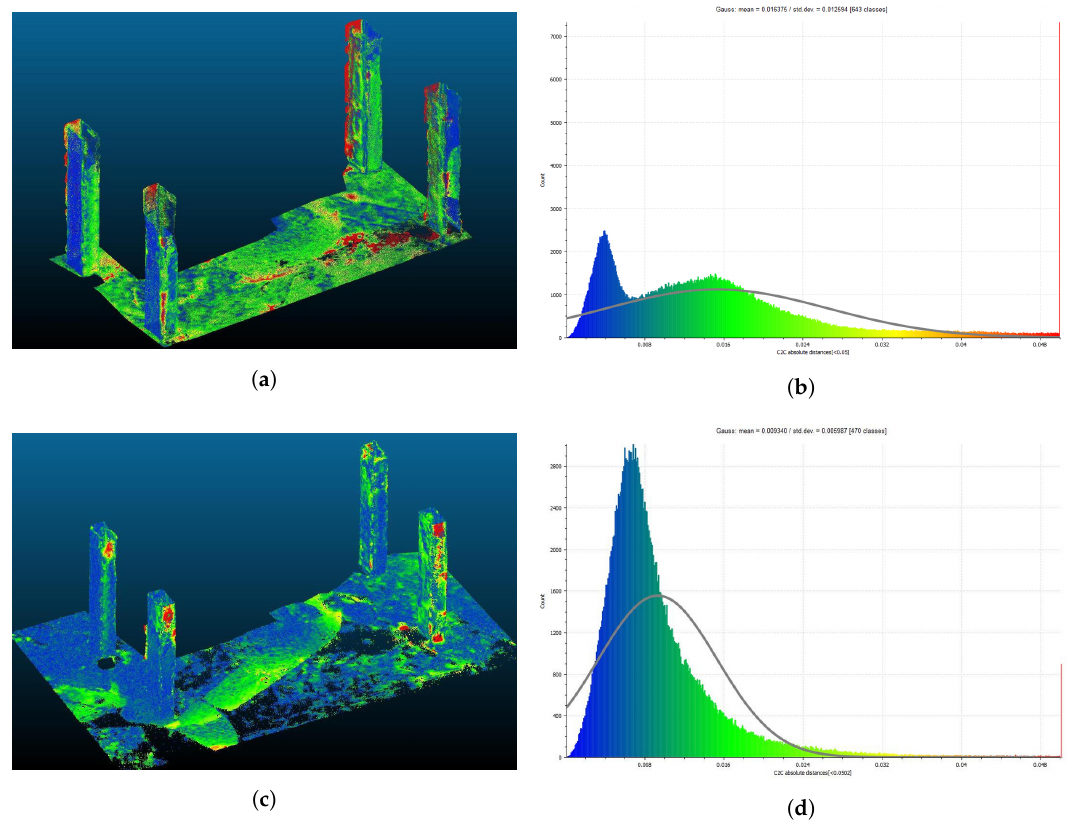
Figure 11. Comparative analysis of an unchanged part of two subsequent datasets. The evaluation is executed both for datasets processed with manually indicated GCPs ( a , b ) as well as with the reference module approach ( c , d ). ( a , c ) Elements coloured according to the deviation (ranging from 0 (blue) to 5 cm (red)). ( b , d ) Histogram of the deviations with a mean of 16 and 9 mm and a standard deviation of 13 and 6 mm,